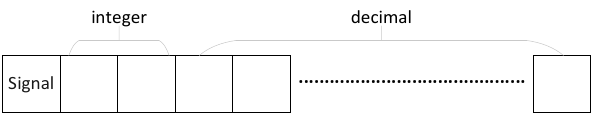
Figure 5. Input phase format of Cordic IP core.